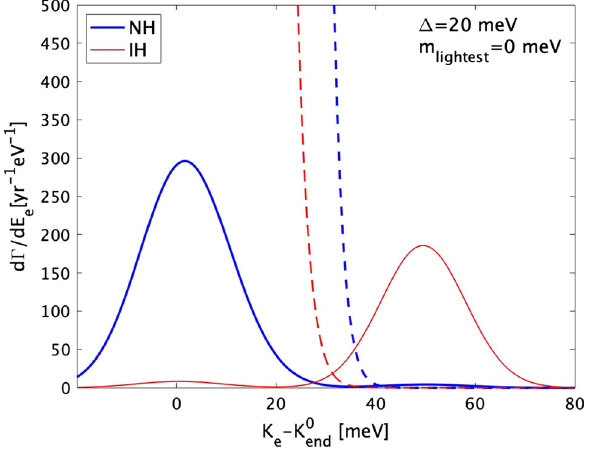
Fig. 2 The expected spectra of the electron kinetic energy, K e = E e − m e , for the C ν B signals (solid lines) and the β -decay background (dashed lines) in a tritium experiment, assuming 100 g of tritium, with the energy resolution (cid:9) = 20 meV in the case of Dirac neutrinos. Bold blue lines represent the NH case and fine red lines represent the IH case. We set m lightest = 0 meV and neglect the neutrino spectral distortions from the decoupling and the gravitational clustering effects